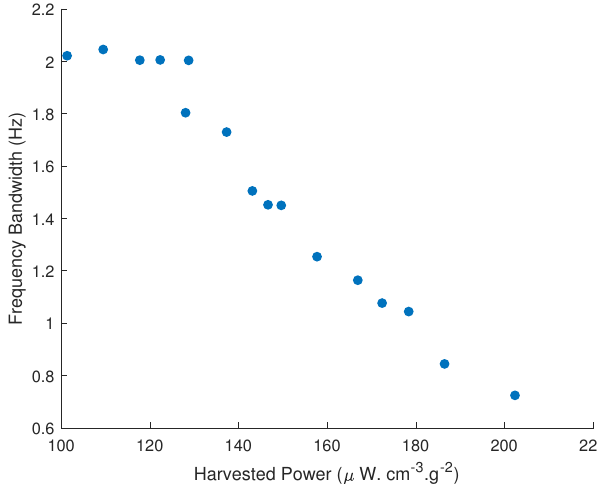
Figure 9. Pareto front of the periodic 5-DOFs system. From these results, it can be concluded that the functionnalization of nonlinearity and mode localization in a multimodal device overcome the challenge of increasing the harvested energy and the frequency bandwidth. Moreover, the combination of